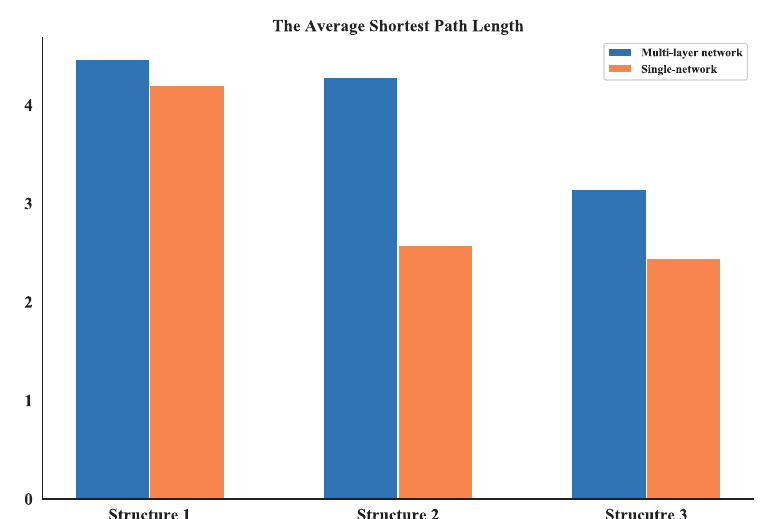
Figure 21. Comparison of average shortest path length between multi-layer network and single network.